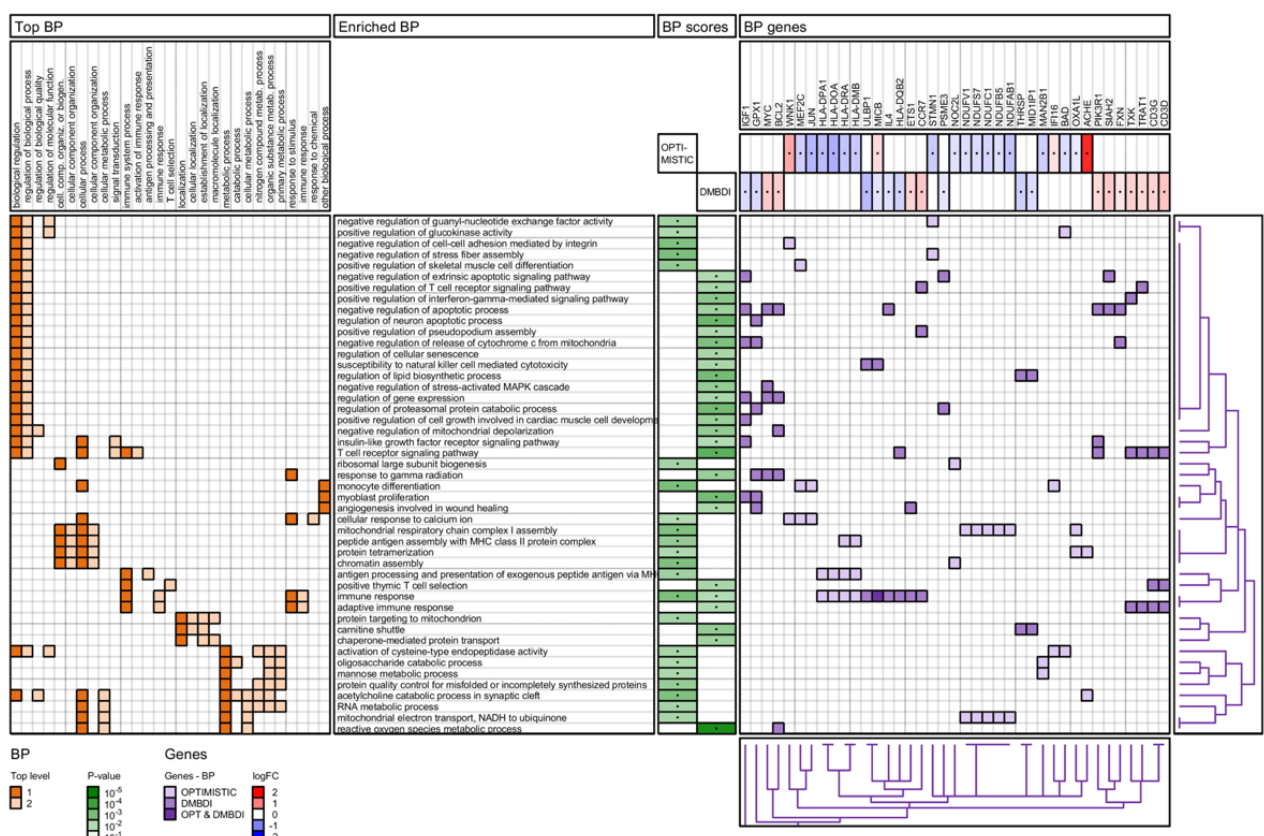
Figure 6. GO biological process (BP) enrichment analysis of OPTIMISTIC and DMBDI genes. For explanation see Section 2.4.